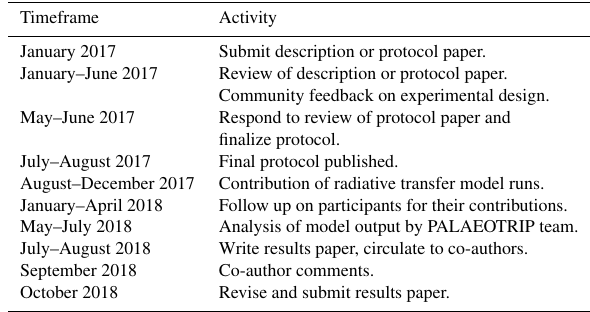
Table 4. Proposed PALAEOTRIP